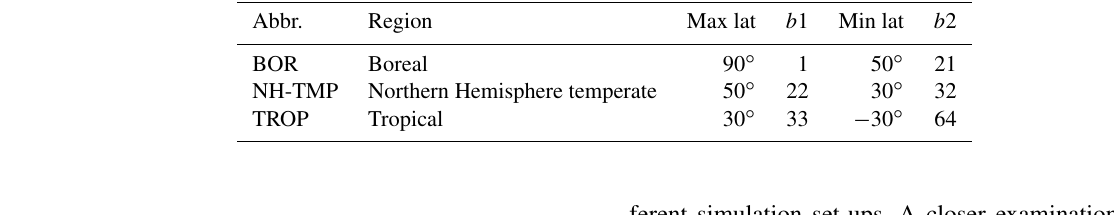
Table 2. Selected regions used for the comparison of simulation results and observation-based data and their latitudinal boundaries and indices. Abbr. Region Max lat b 1 Min lat BOR